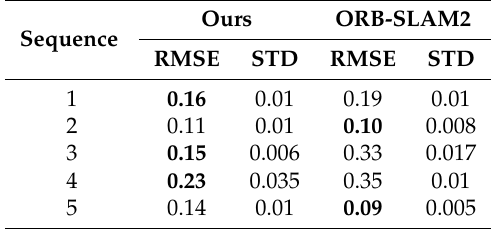
Table 3. Accuracy performance on the warehouse